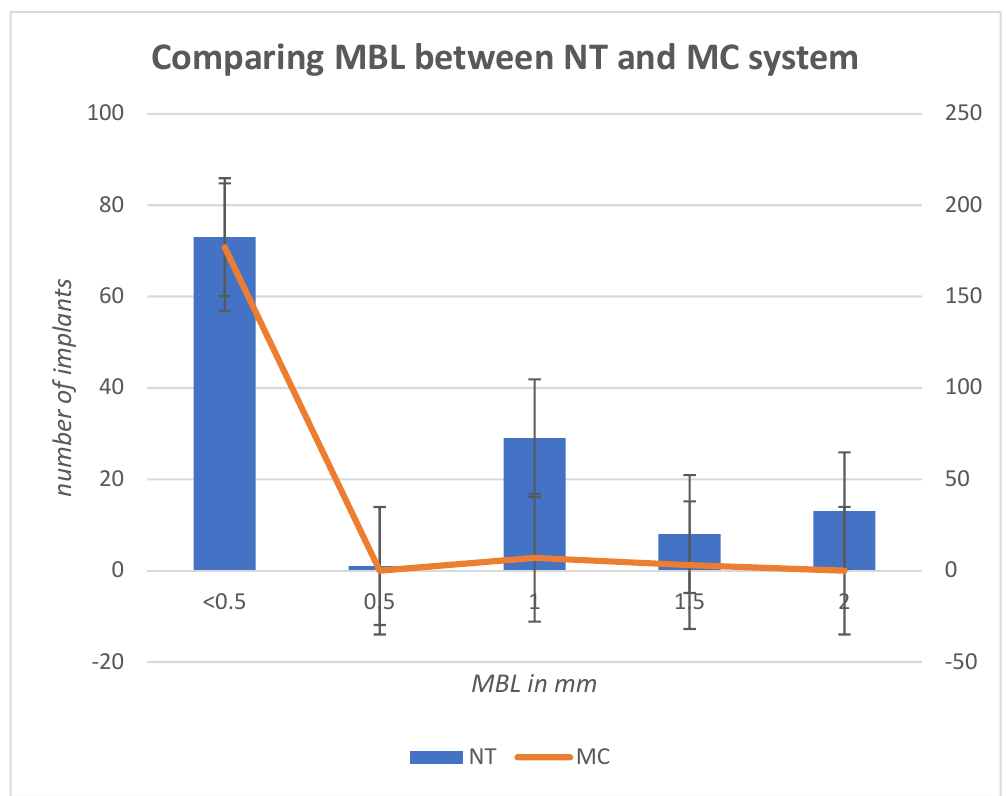
5 of 8 Table 1. Demographics and MBL measurement for NT and MC implants. Demographics and MBL Measurement for NT and MC Implants NT (124)